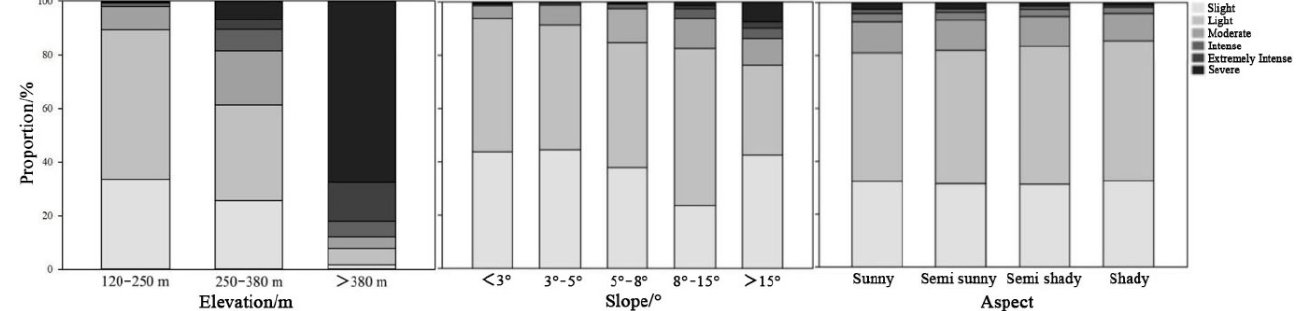
Figure 6. Proportion of soil erosion grades of cultivated land at different altitudes, slopes, and aspects. 3.3. Land Use Factor Analysis of Cropland Soil Erosion Based on the GWR Model Table 3 shows that the VIF of the independent variables was less than 5 and the condition index was less than 30, which proved that the nine explanatory variables selected passed the multicollinearity test. Table 3. Multicollinearity test results of independent variables.